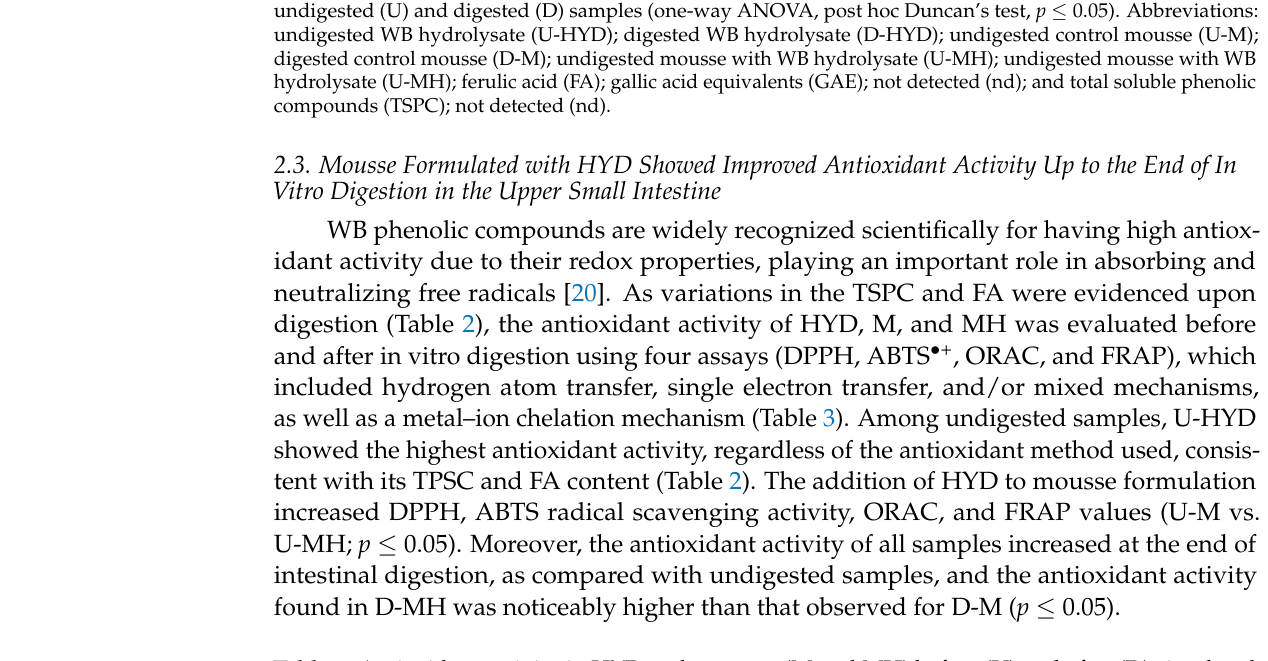
Table 3. Antioxidant activity in HYD and mousses (M and MH) before (U) and after (D) simulated gastrointestinal